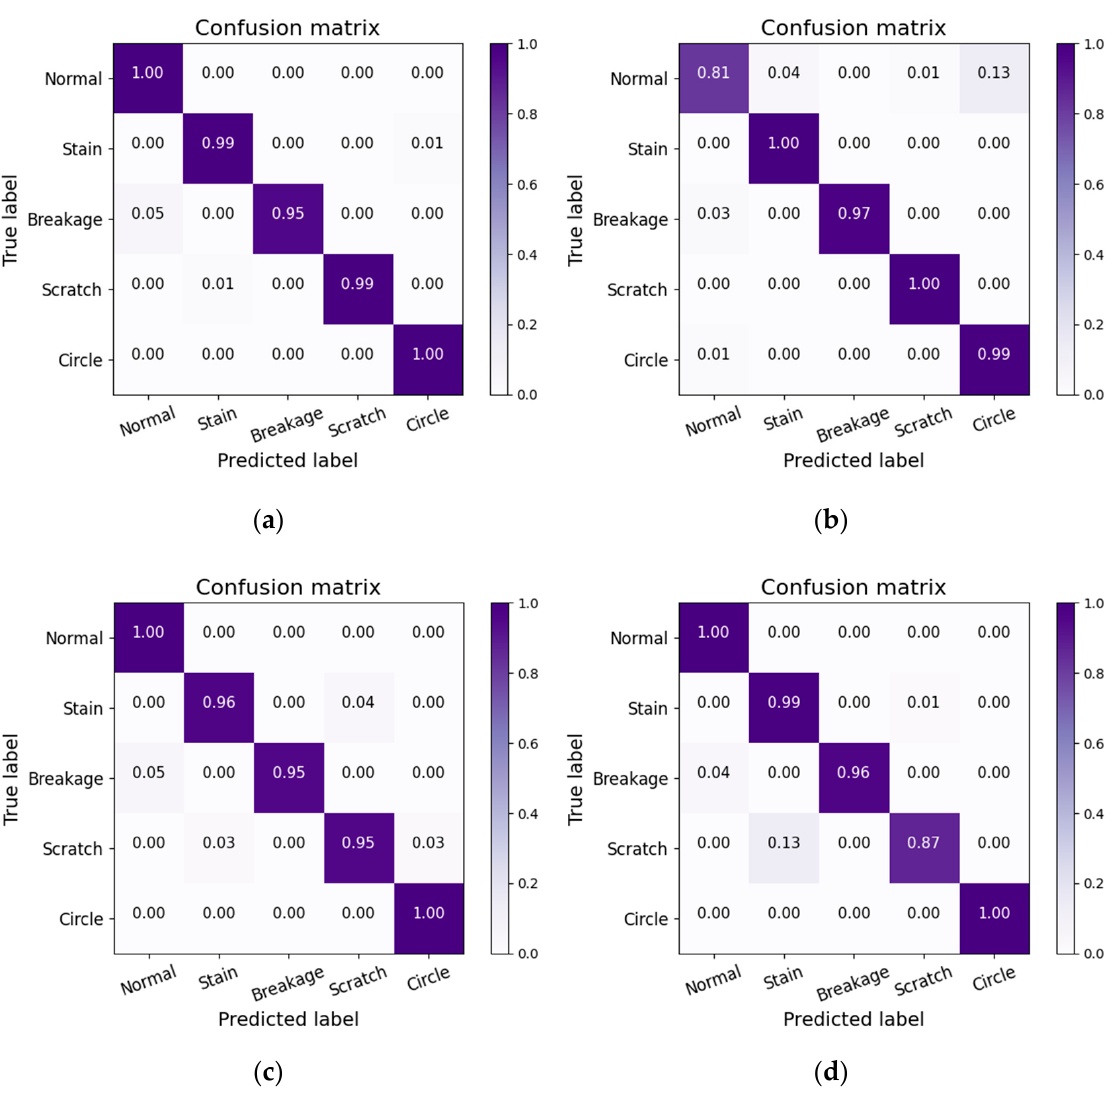
Figure 9. Normalized confusion matrix of the gear end classification for different networks: ( a ) Proposed model with GAN; ( b ) proposed model without GAN; ( c ) Vgg11; ( d ) Vgg16.